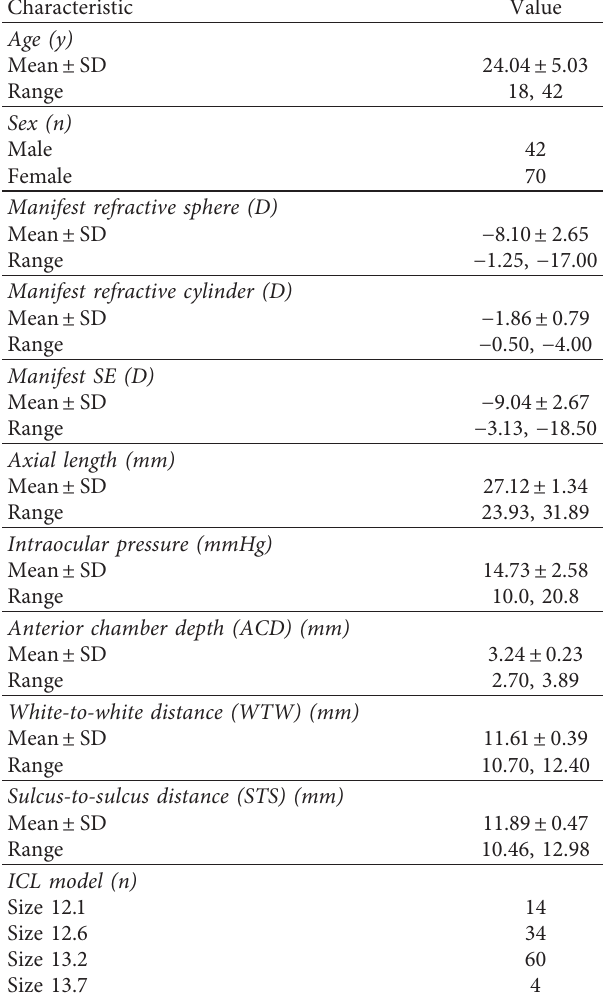
Table 1: Preoperative patient clinical